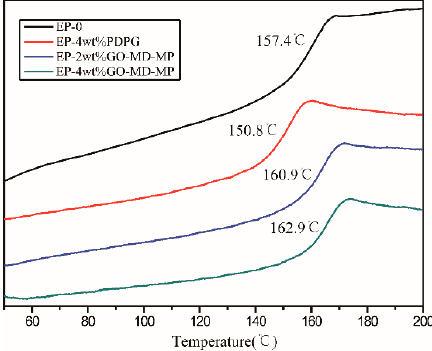
Figure 11. The DSC curves of pure EP and its different cured EP composites.